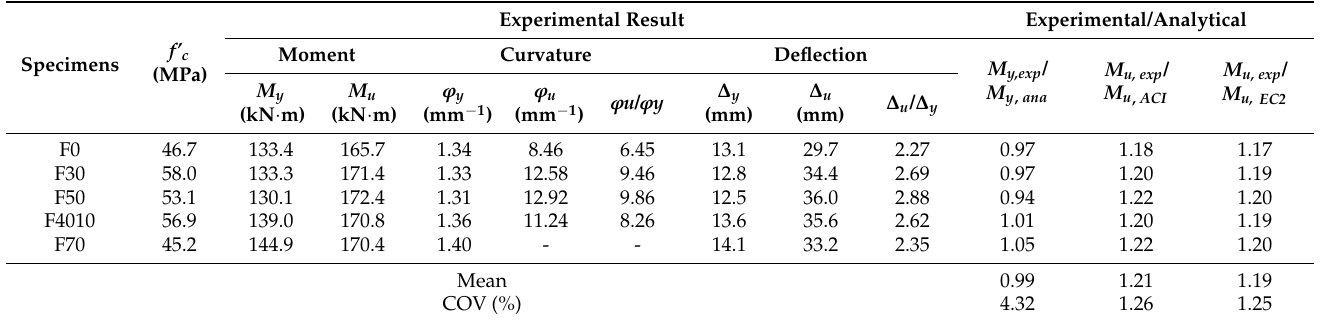
Table 3. Comparison between analytical and experimental results of F series.